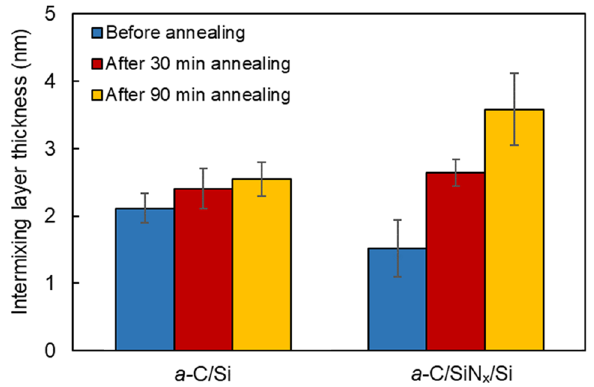
Figure 5. Intermixing layer thickness in a -C/Si and a -C/SiN x /Si stacks measured before and after RTA at 250 °C in Ar atmosphere for 30 and 90 min.